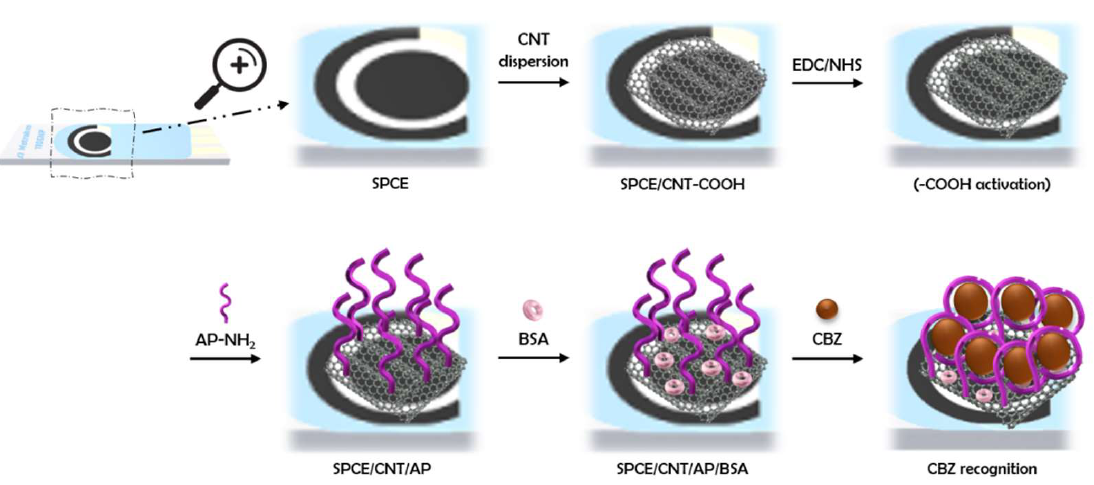
Scheme 1. Schematic illustration of the fabrication of an electrochemical aptasensor for CBZ detection.